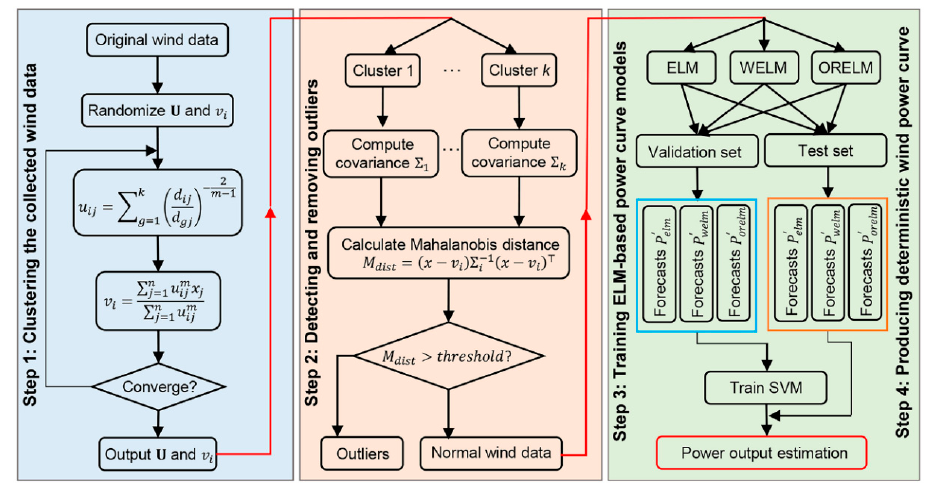
Figure 2. The flowchart of the proposed hybrid model.